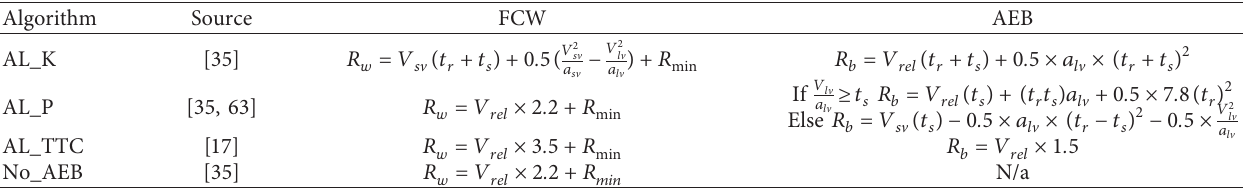
Table 3: FCW and AEB algorithms.